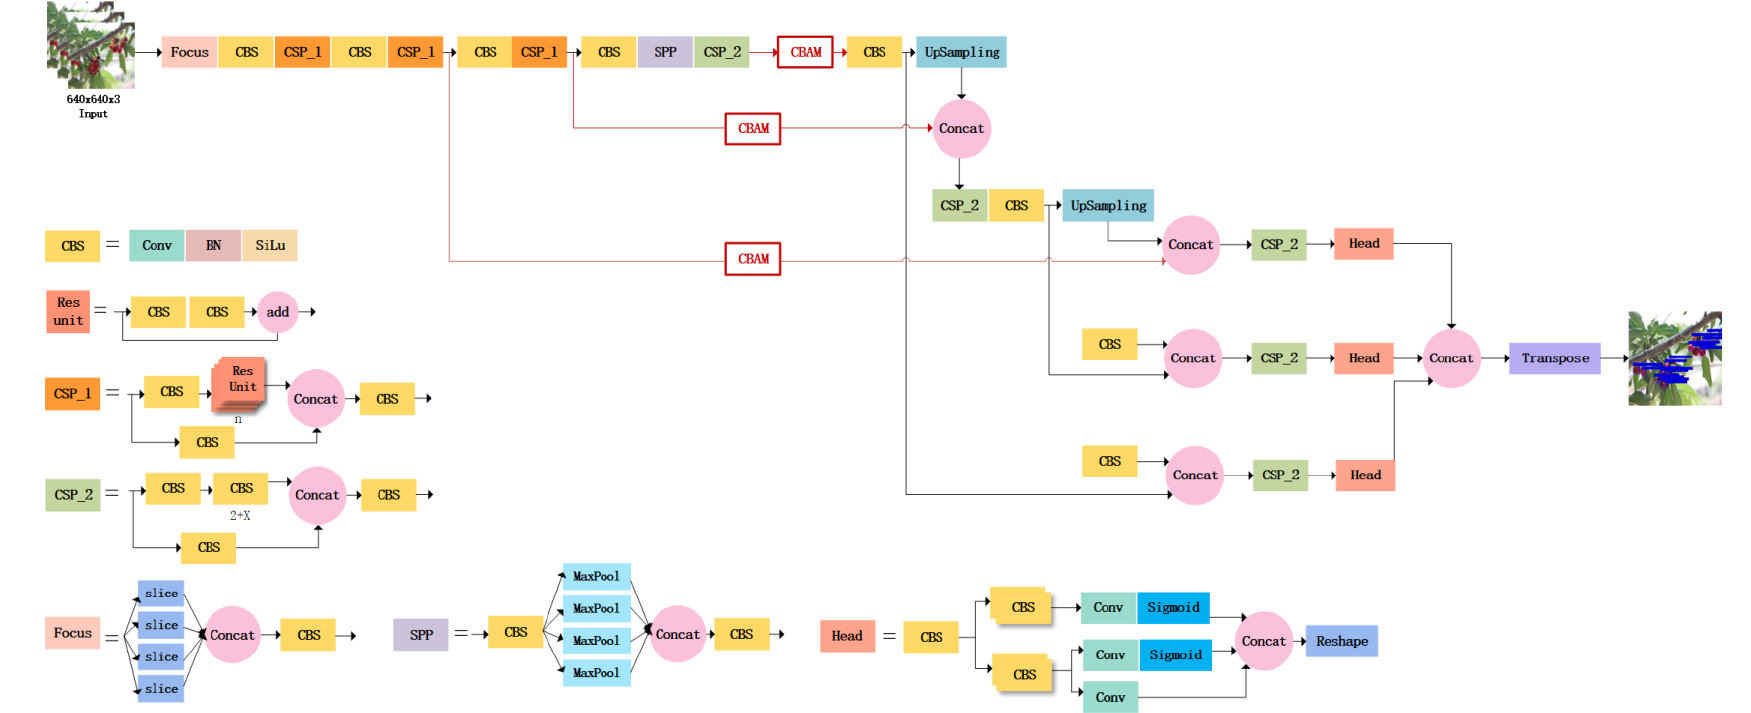
Figure 3. The architecture of YOLOX-EIoU-CBAM.